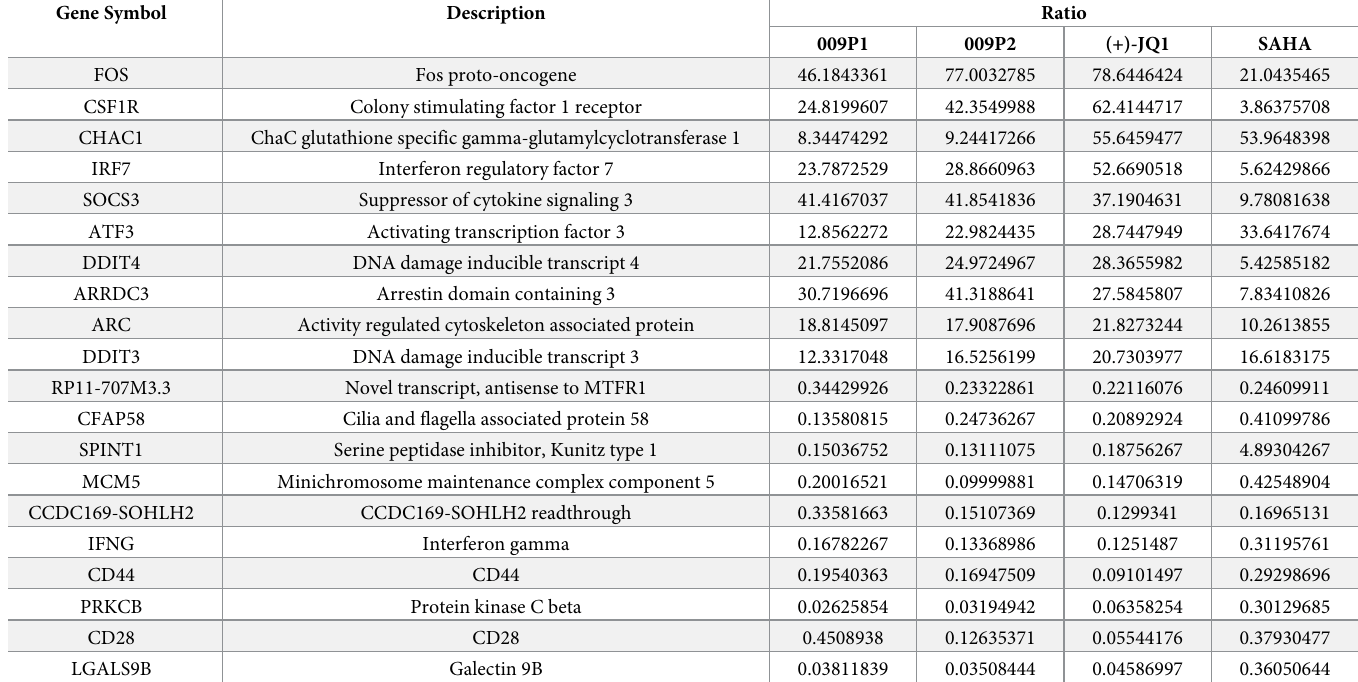
Table 3. The top 10 common genes upregulated or downregulated from 009P1-, 009P2-, (+)-JQ1- and SAHA-treated BCBL-1 cells. Gene